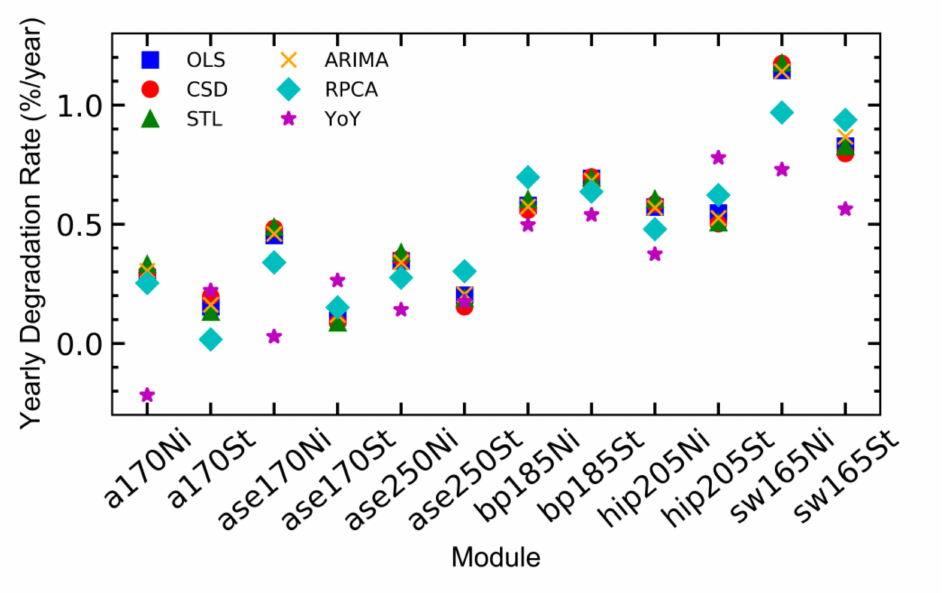
Figure 10. Comparison of the yearly R D of each PV system installed at both locations, over the 12-year evaluation period. The orange bar and green triangle depict the median and mean value, respectively. The purple square depicts the 8-year R D measured using indoor standardized